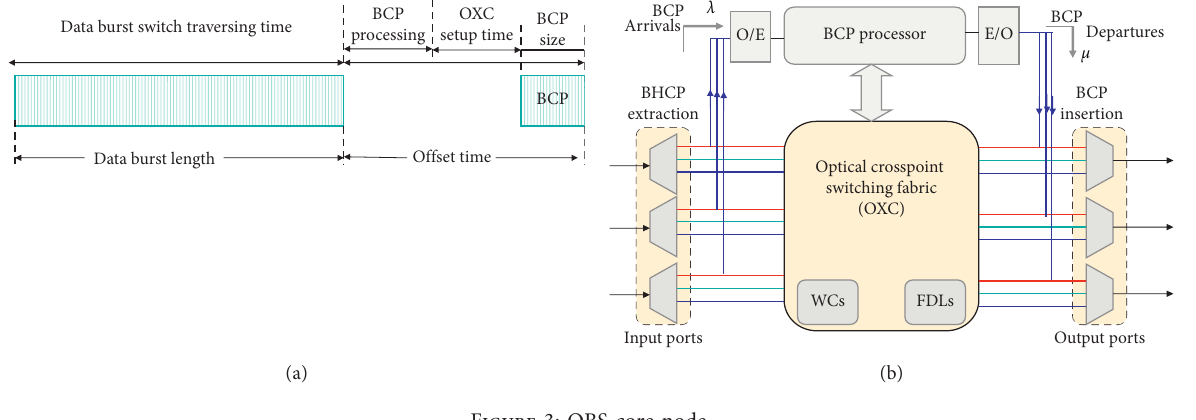
Figure 3: OBS core